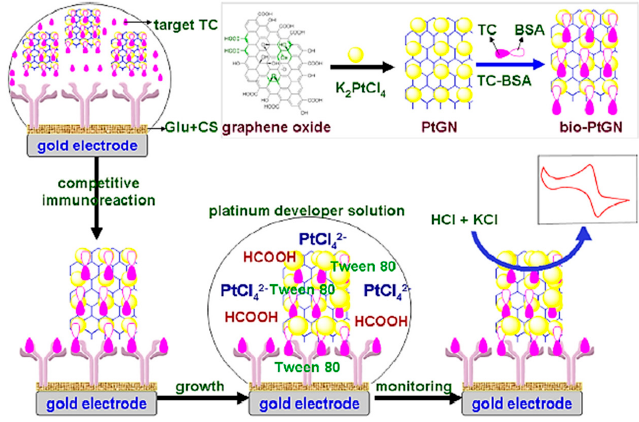
Figure 5. Schematic representation of electrochemical immunosensor based on platinum-catalyzed hydrogen evolution reaction for the detection of tetracycline (reprinted with permission from Que et al. [66]).